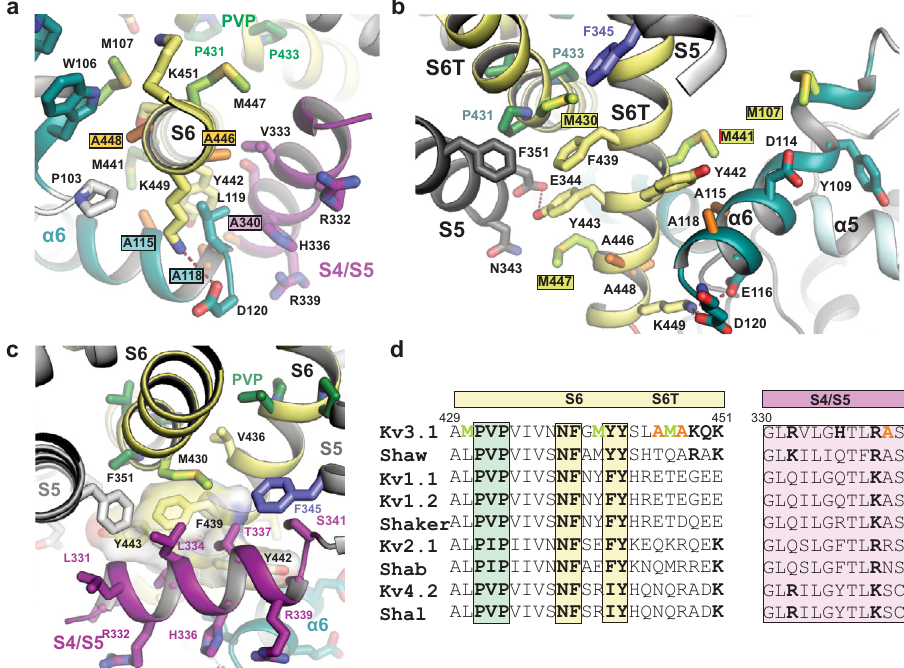
Fig. 5 A cluster of Kv3-speci fi c alanines allows three-way interactions between α 6, S4/S5 linker and S6T and location of Kv3.1-speci fi c methionines in S6T. a Cytoplasmic view onto S6T (pale yellow cartoon) of the lower gate in Kv3.1a, highlighting the close proximity to neighbouring helices S4/S5 and α 6 of the T1 domain, which is possible due to the compact side chains of A115 and A118 ( α 6), A340 (S4/S5 linker) and A446 and A448 (S6T). The close contact allows the formation of a stabilizing salt bridge between D120 in α 6 and K449 in S6T. b Rotated view from a , highlighting the abundance of Kv3- speci fi c methionines in S6T (M430, M441, M447) and α 6 (M107). S4/S5 linker is omitted for clarity. Red frame indicates the location variant M441L associated with EPM7. c Illustration of the hydrophobic surface created by aromatic S6T residues F439, Y442, and Y443 (displayed as semi-transparent surfaces) which cradles the S4/S5 linker (magenta) close to the PVP motif (green sticks) and the α 6 helix in the T1 domain. F345 in S5 (slate blue) and M430 (lime green) from adjacent subunits form a sulfo-aromatic interaction. d Sequence alignment of the S6/S6T (left) and S4/S5 linker (right) regions of Kv3.1a with other T1-containing Kv channels (human or fruit fl y). Kv3-speci fi c alanines and methionines are highlighted in orange and lime, respectively. Conserved residues across other Kv families are shown in bold, including the PVP motif (green) and the aromatic S6T residues involved in electromechanical coupling interactions with the S4/S5